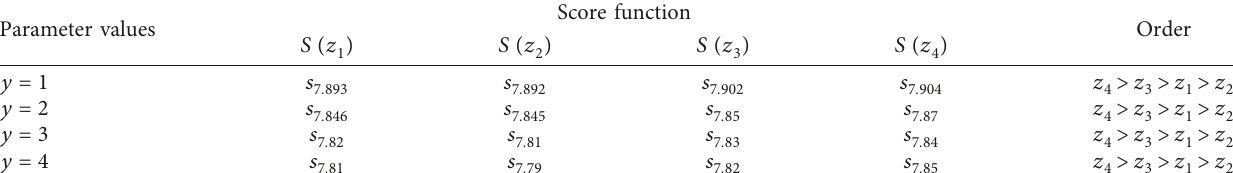
Table 20: Order for different parameters with LFFWHM